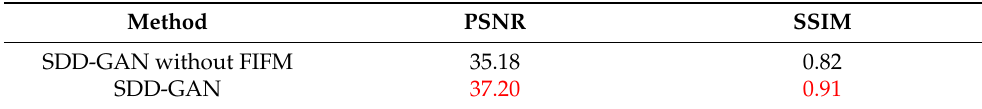
Table 6. Mean PSNR and SSIM (with FISM vs. without FISM) on the RSDATA dataset. The highest scores are highlighted in red.